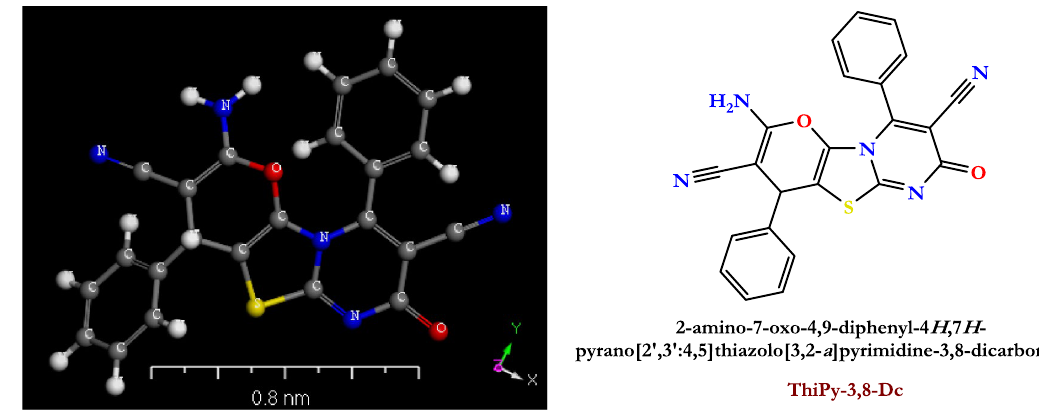
Figure 1. The chemical structure and 3D of the fabricated organic compound